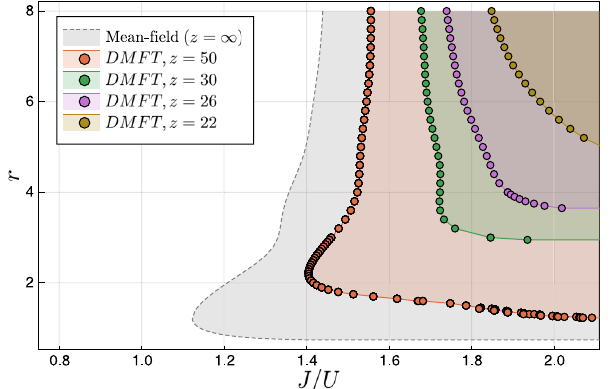
FIG. 2. Phase diagram of the Bose-Hubbard model [see Eqs. (3) – (5)] obtained with DMFT and NCA, as a function of pump/loss ratio r and hopping/interaction ratio J=U , for different values of the lattice connectivity z , compared to the Gutzwiller J Þ separates a normal mean-field one ( z ¼ ∞ ). A critical line r c ð low-hopping phase from a broken symmetry phase where the system develops a local order parameter oscillating in time at finite frequency. Decreasing the lattice connectivity, i.e., increas- ing quantum fluctuations due to the finite number of neighbors, the ordered phase shrinks and the entire phase boundary is reshaped. In particular, the reentrant behavior of the normal phase found in the mean field disappears at small values of z . 10 , and dim 10 Parameters: η =U ¼ 0 . 02 , dt ¼ 0 . 004 , t H ¼ max ¼ (see Sec.